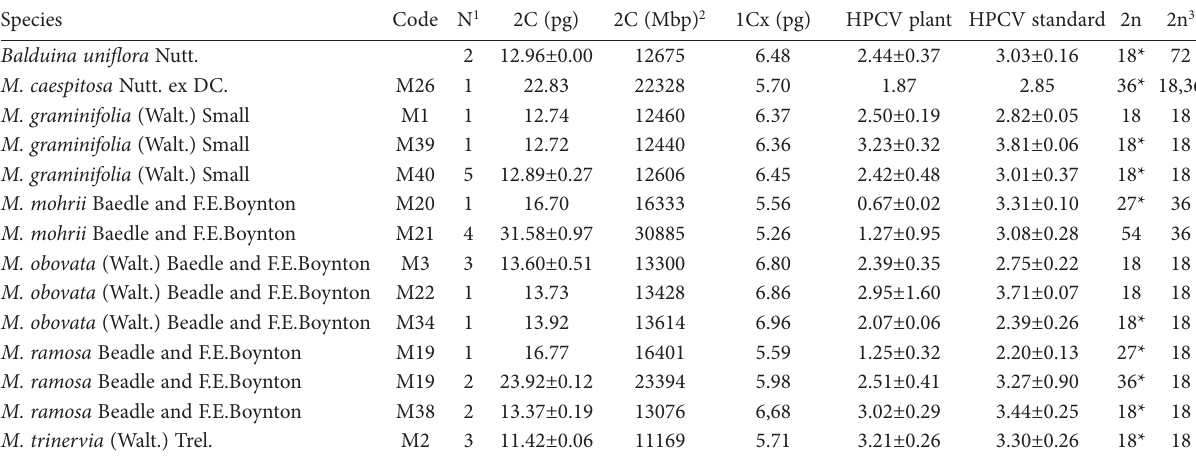
Table 2. Marshallia and Balduina species studied including genome size measurements and chromosome counts. Species Balduina uniflora Nutt.